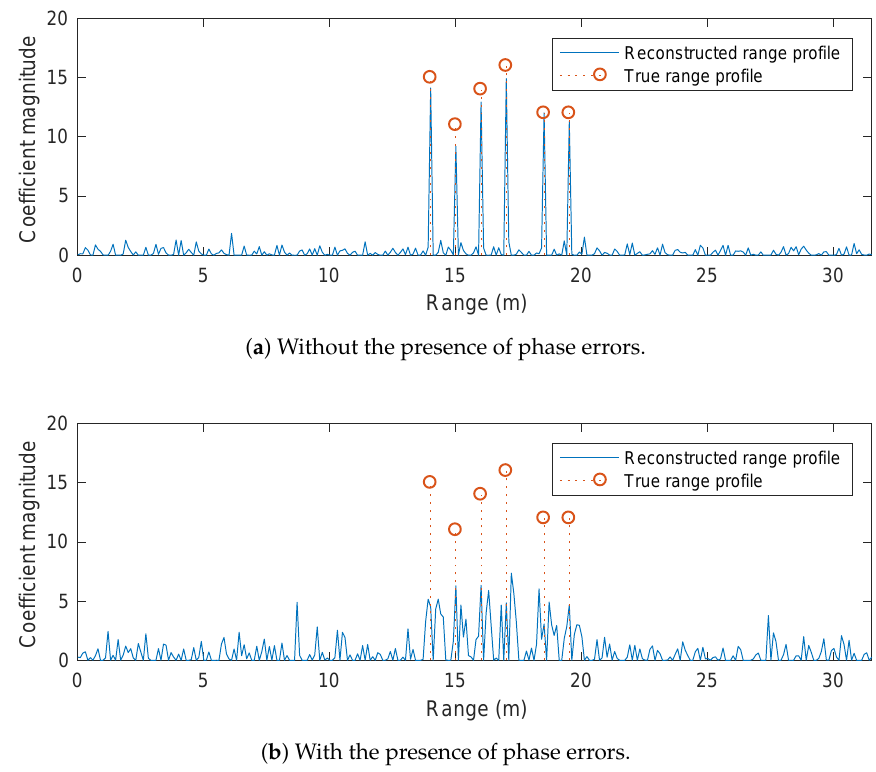
( b ) With the presence of phase errors. Figure 3. Performance of conventional l 1 -norm regularised optimisation solver.